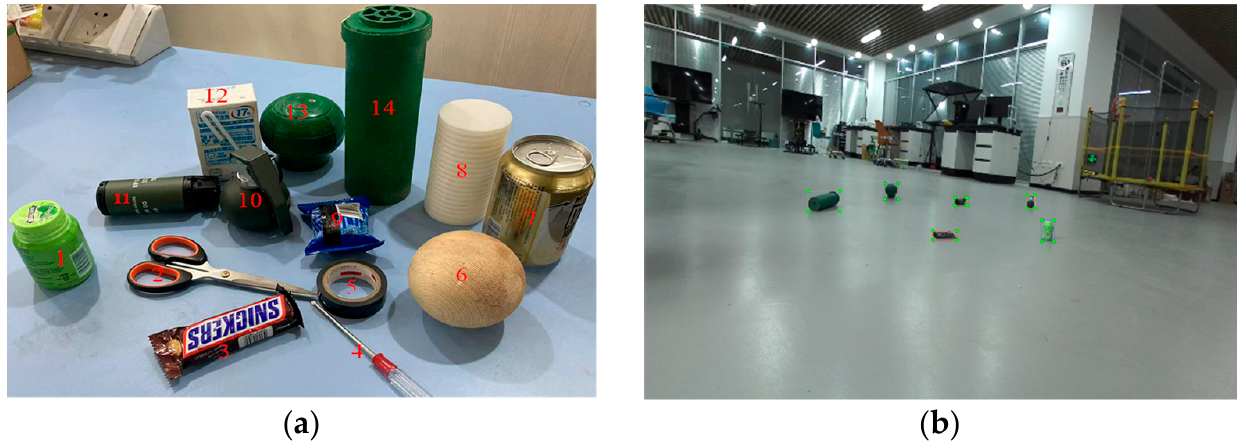
Figure 7. The introduction to the dataset. ( a ) 14 objects in the dataset. The ground truth labels 1 to 14 are chewing_gum, scissors, snickers, screwdriver, tape, wooden_ball, beer, cylinder, biscuit, grenade, flashbang, milk, landmine, and smoke_bomb; ( b ) The collection environment of the da- taset.